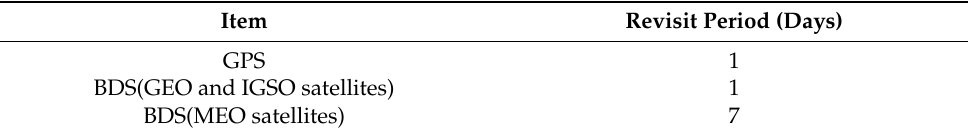
Figure 9. Trajectories of BDS satellites. Table 2. Revisit periods of GPS and BDS constellations.